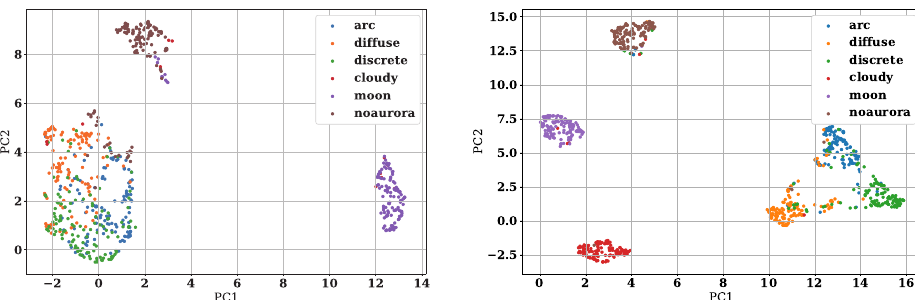
Figure 4. These are features obtained by the Triplet Margin Loss model compressed to 2 dimensions. The left part shows the features of the first epoch of fold 0 and the lower part is one of epoch 15 of fold 0.